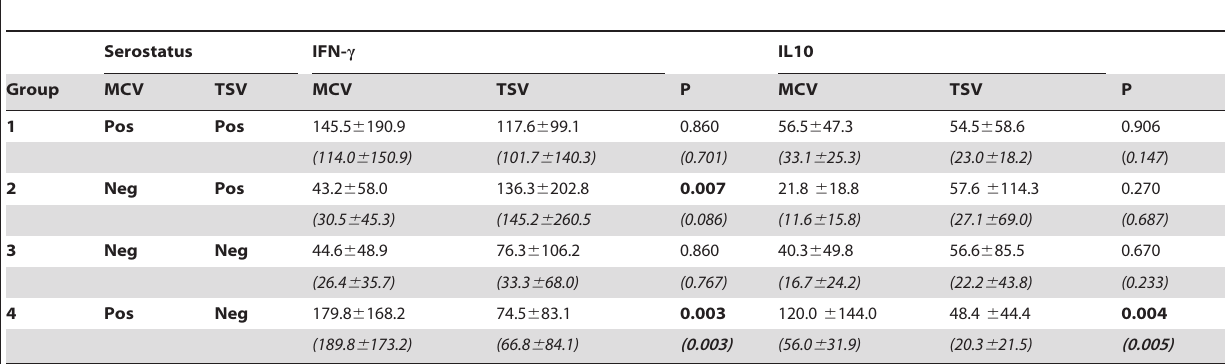
Table 3. Comparison of MCV and TSV-specific IFN- c and IL-10 (pg/ml 6 SD) responses in the different groups (responses at 0.5 m g/ ml concentration are shown in parentheses below responses at 1.5 m